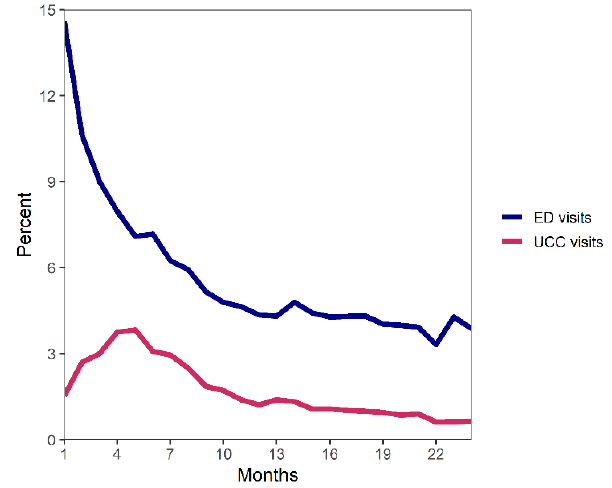
Figure 1. Percentage of individuals diagnosed with cancer that had a UCC or ED visit by number of months since the start of eligibility time frame (3 months prior to first scheduled CancerCare Manitoba (CCMB) visit or, if first CCMB visit occurred prior to diagnosis, date of diagnosis).